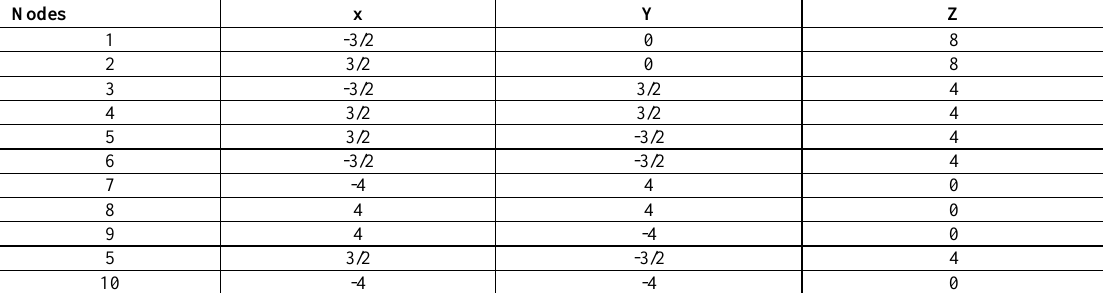
Table 1. Coordinate systems with respect to x, y, and